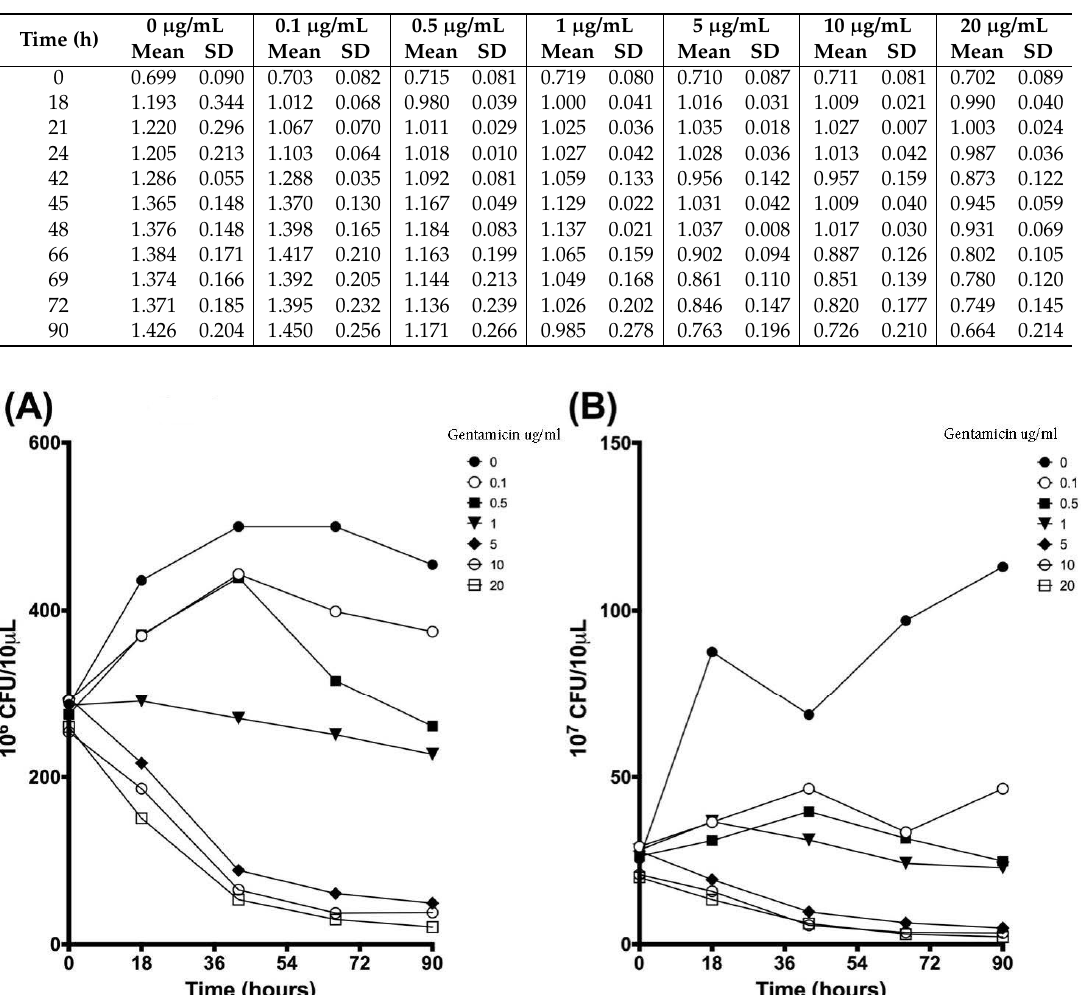
Table 1. Mean and standard deviation of optical density (OD 600 ) for M. avium with gentamicin treatment over 90 h, n = 3.